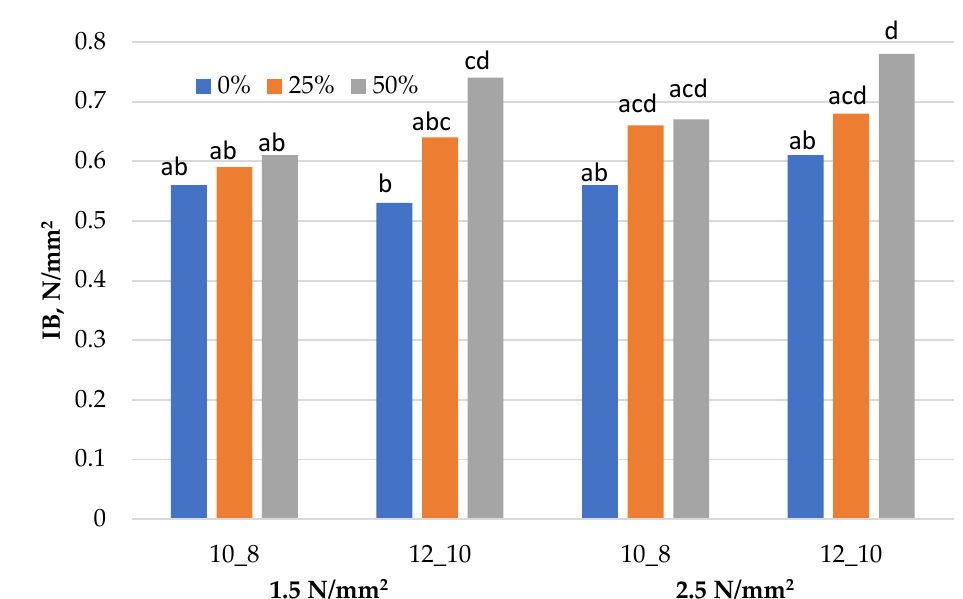
Figure 2. Modulus of elasticity (MOE) of particleboards produced.